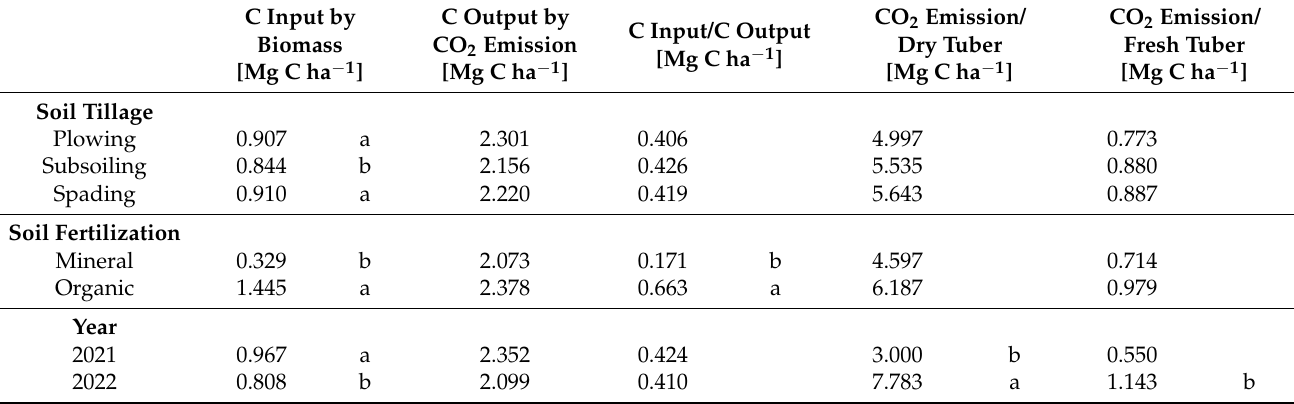
Table 2. The carbon balance in the potato crop and the effects related to soil tillage practice, fertiliza- tion source, and year. Different letters for each main effect indicate statistically significant differences according to LSD test ( p < 0.05). No letters mean that differences between the means were not significant ( p >